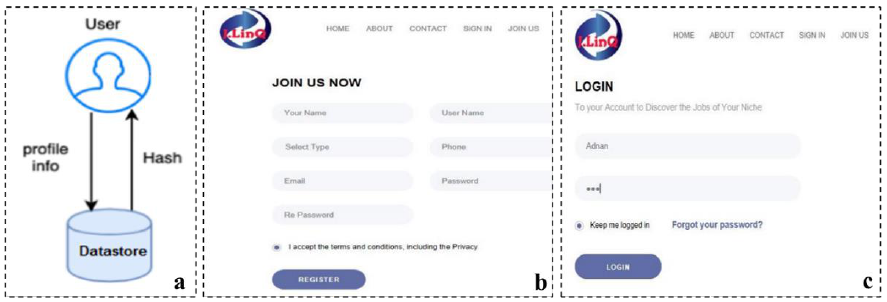
Figure 7. Prototype design includes ( a ) users profile creation in the system, ( b ) registration interface of the system, and ( c ) login interface of the